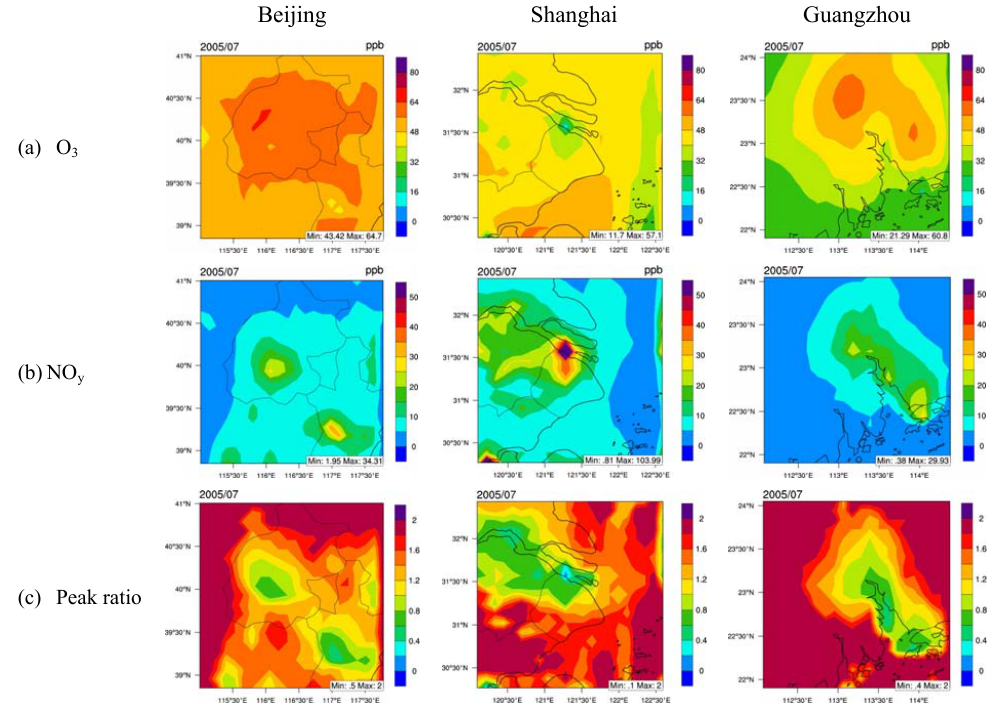
Fig. 8. Ozone chemistry variations in Beijing, Shanghai and Guangzhou (Monthly mean of Ozone, NO y mixing ratio, and Peak ratio during afternoon time, 12:00–17:00, July 2005).